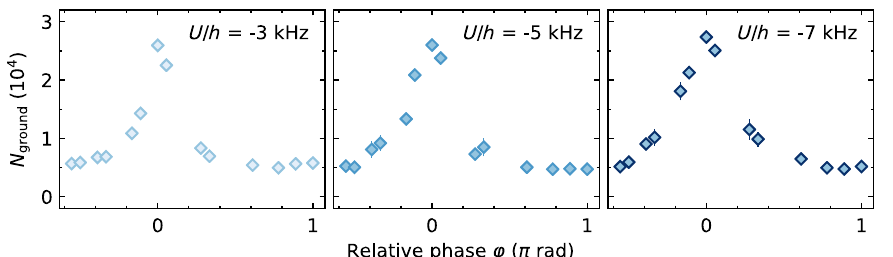
FIG. 8. Effect of interactions on the optimum canceling phase. The measurement of Fig. 2(b) in the main text is repeated for three different values of Hubbard U , namely, − 3 kHz (left), − 5 kHz (middle), and − 7 kHz (right). The optimum relative driving phase φ does not shift as a function of the interaction